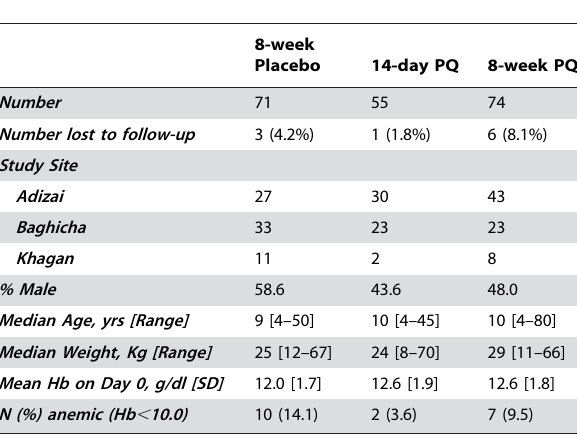
Table 2. Number (%) with treatment failure in each treatment group over the 11 month observation period, by sex, age group and village.